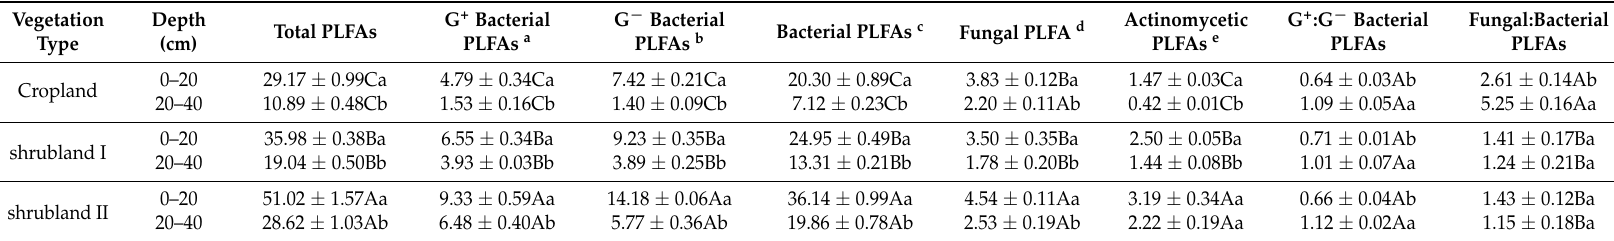
Different lowercase letters indicate significant differences at p < 0.05 between soil depths for each vegetation type; different capital letters indicate significant differences at p < 0.05 among different vegetation types at a same depth. a a14:0, i14:0, i15:0, a16:0, i16:0, a17:0, i17:0; b 16:1 ω 5c, 16:1 ω 7, 16:1 ω 9, cy17:0, 18:1 ω 7, cy19:0, 16:1 ω 7t, 17:1 ω 8c; c 14:0, 15:0, 16:0, 17:0,